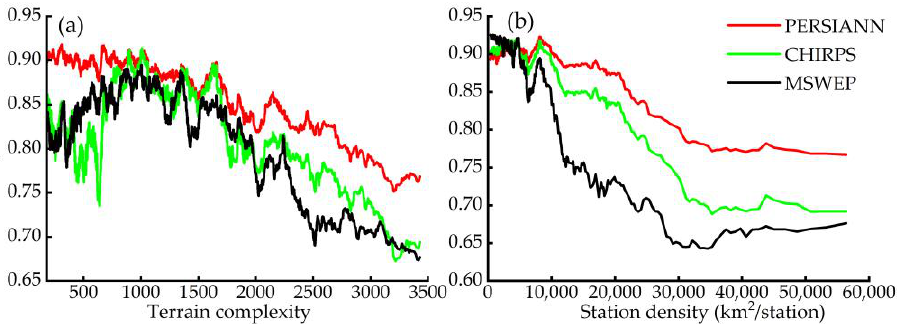
Figure 12. Variation of the correlation coefficients between the three RSPEs and CMA along with changes in terrain complexity ( a ) and station density ( b ). changes in terrain complexity ( a ) and station density ( b